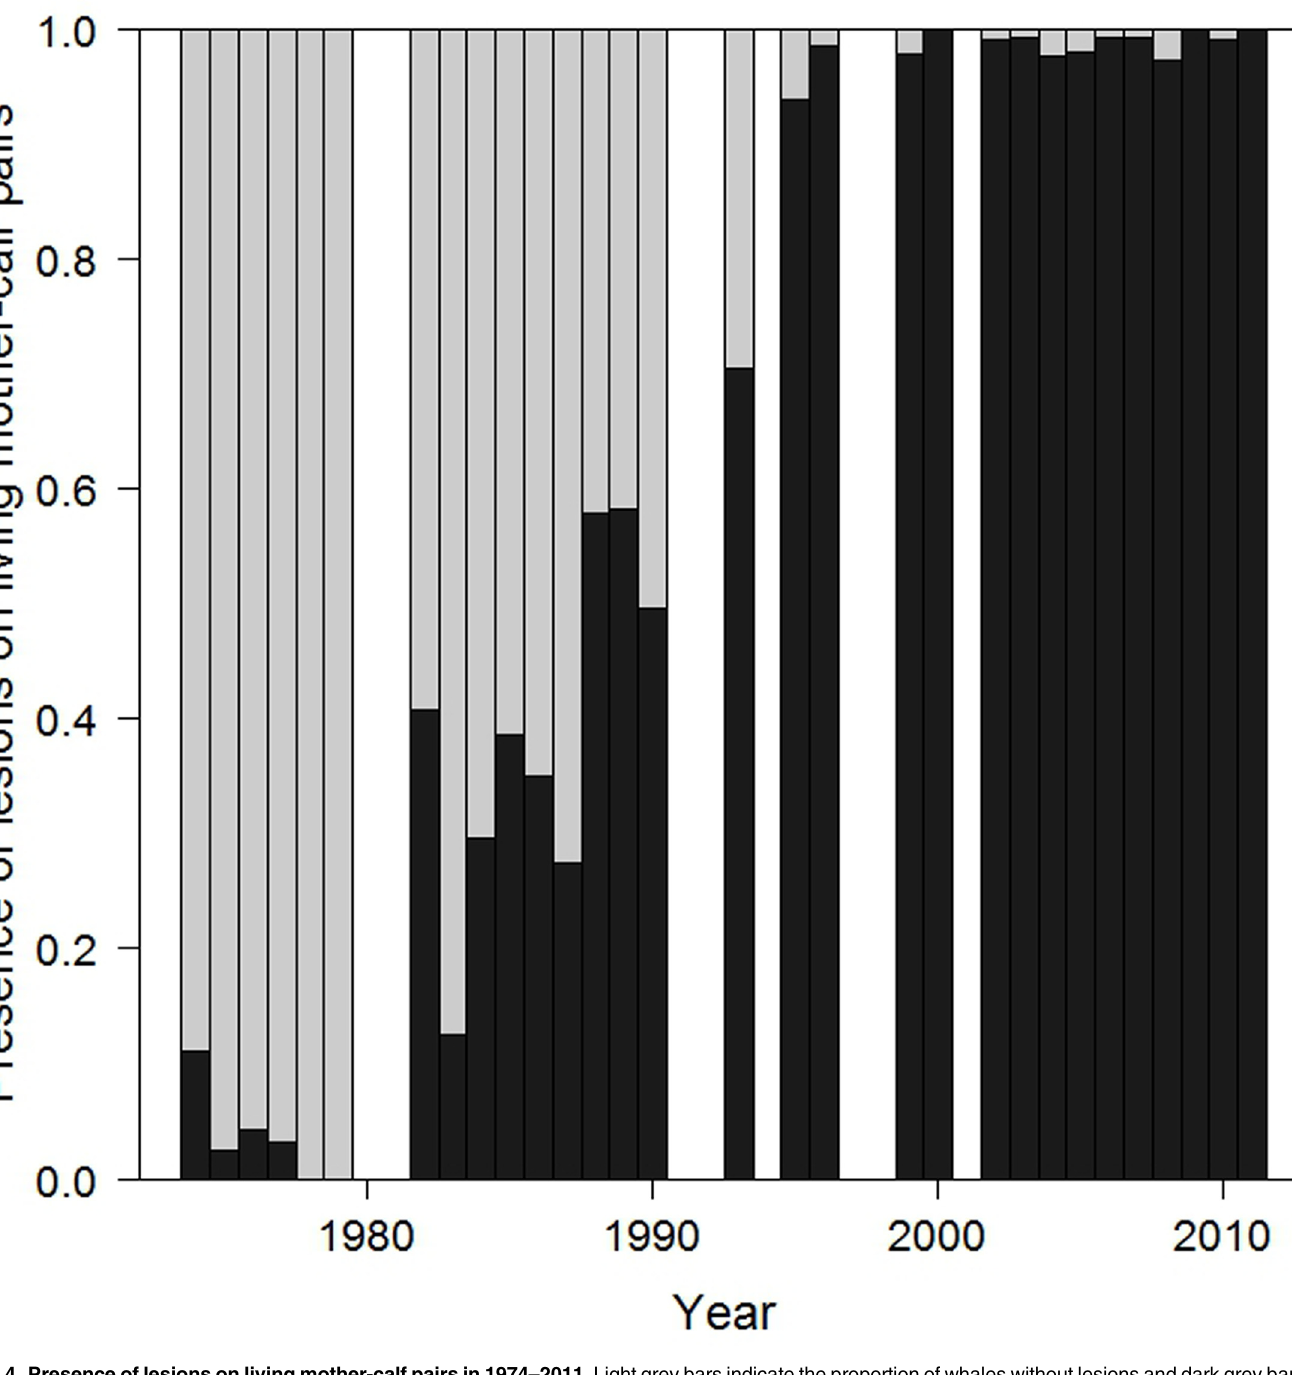
Fig 4. Presence of lesions on living mother-calf pairs in 1974 – 2011. Light grey bars indicate the proportion of whales without lesions and dark grey bars indicate the proportion of whales with lesions. White columns indicate years excluded from the study. lesions (56.3%) and without them (43.7%). Compared to living calves, number (n = 186) and area (n = 177) of lesions were determined in fewer dead calves because of poor photo quality, back exposure or skin decay. The average number of lesions on dead calves was four (range: